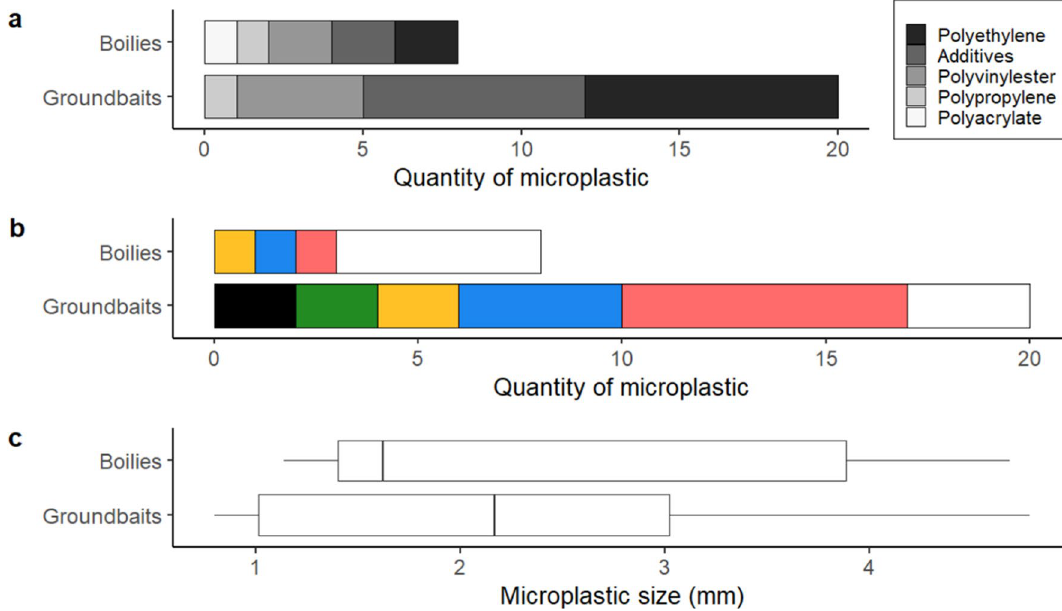
Figure 3. Characteristics of microplastics found in boilies (n = 8) and groundbaits (n = 20): ( a ) polymer composition, ( b ) colour (as displayed) and ( c ) size (mm).